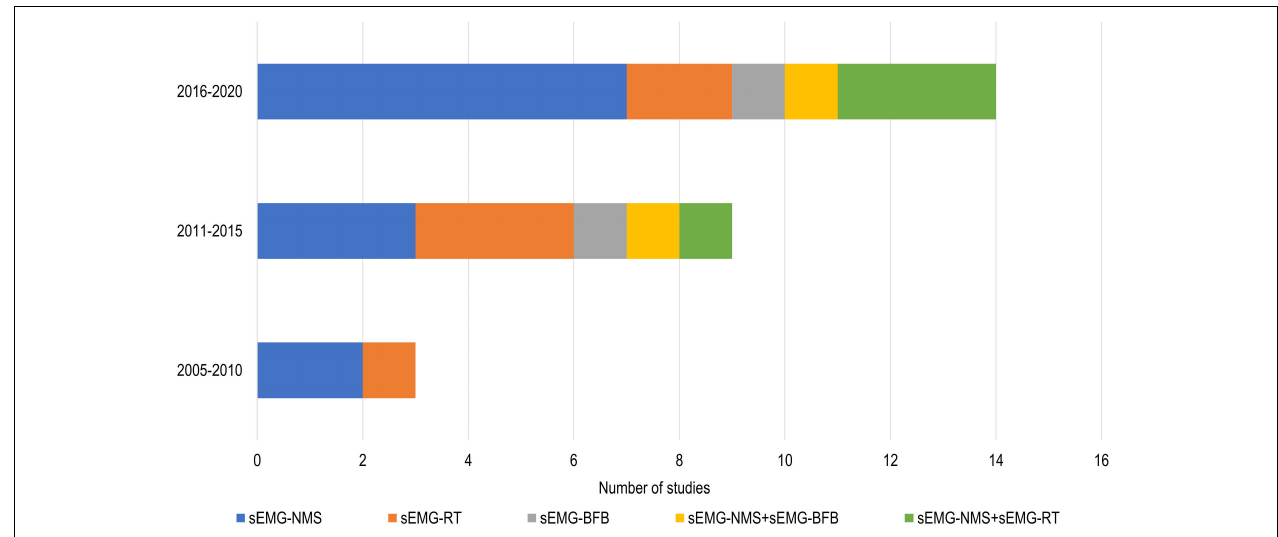
FIGURE 4 | Number of studies using different sEMG interventions shown over time. s-EMG, surface electromyography; sEMG-NMS, sEMG triggered neuromuscular stimulation; sEMG-RT, s-EMG driven robot therapy; sEMG-BFB, sEMG providing visual and/or auditory biofeedback; +, combine